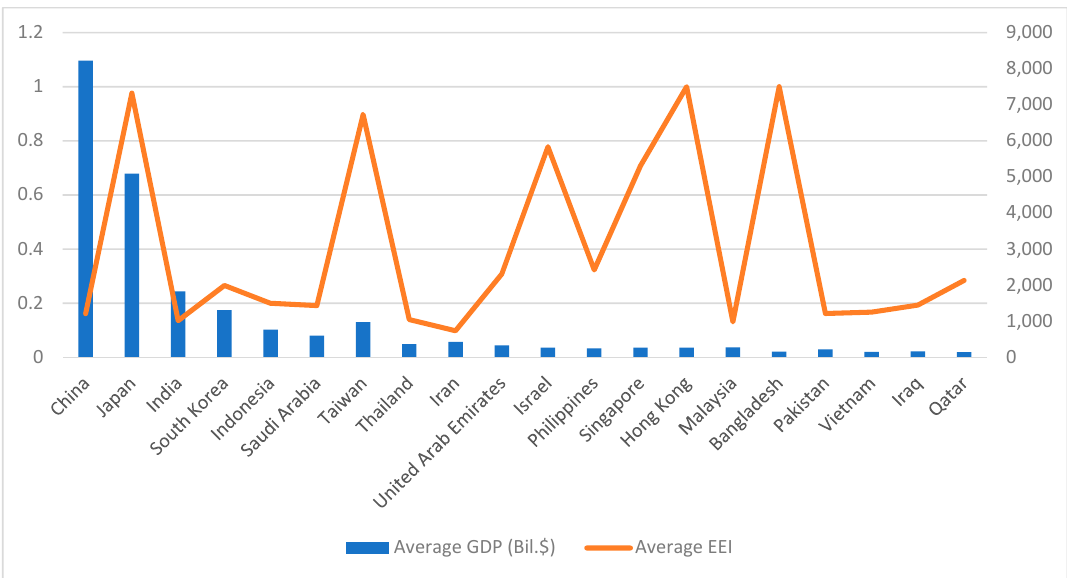
Figure 4. Comparison between the average EEI and the average Volume of Vehicles. Source: authors’ estimation.